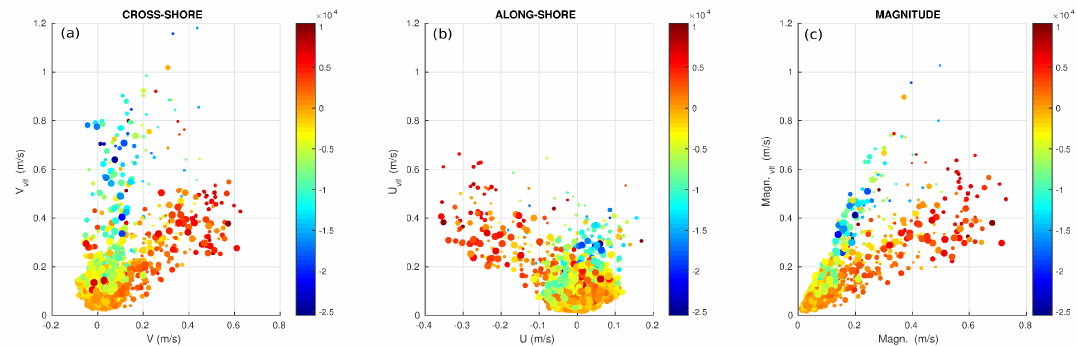
Figure 8. Significant amplitude of very low frequency (VLF) fluctuations (above 5min period) vs mean current for the cross-shore ( a ) and along-shore ( b ) components and magnitude ( c ) for the depth-averaged velocity. Longshore power and tidal elevation are depicted by color levels and marker size (the larger, the higher),